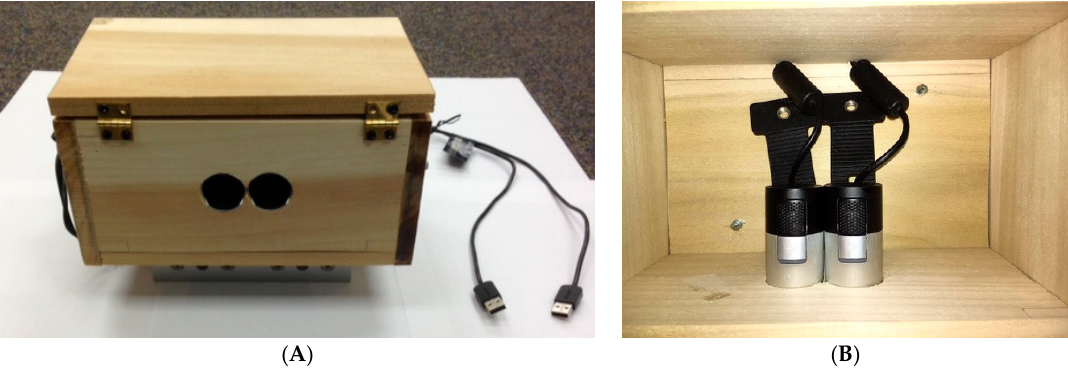
Figure 1. Stereo cameras which are used to acquire images: ( A ) whole view; ( B ) inside